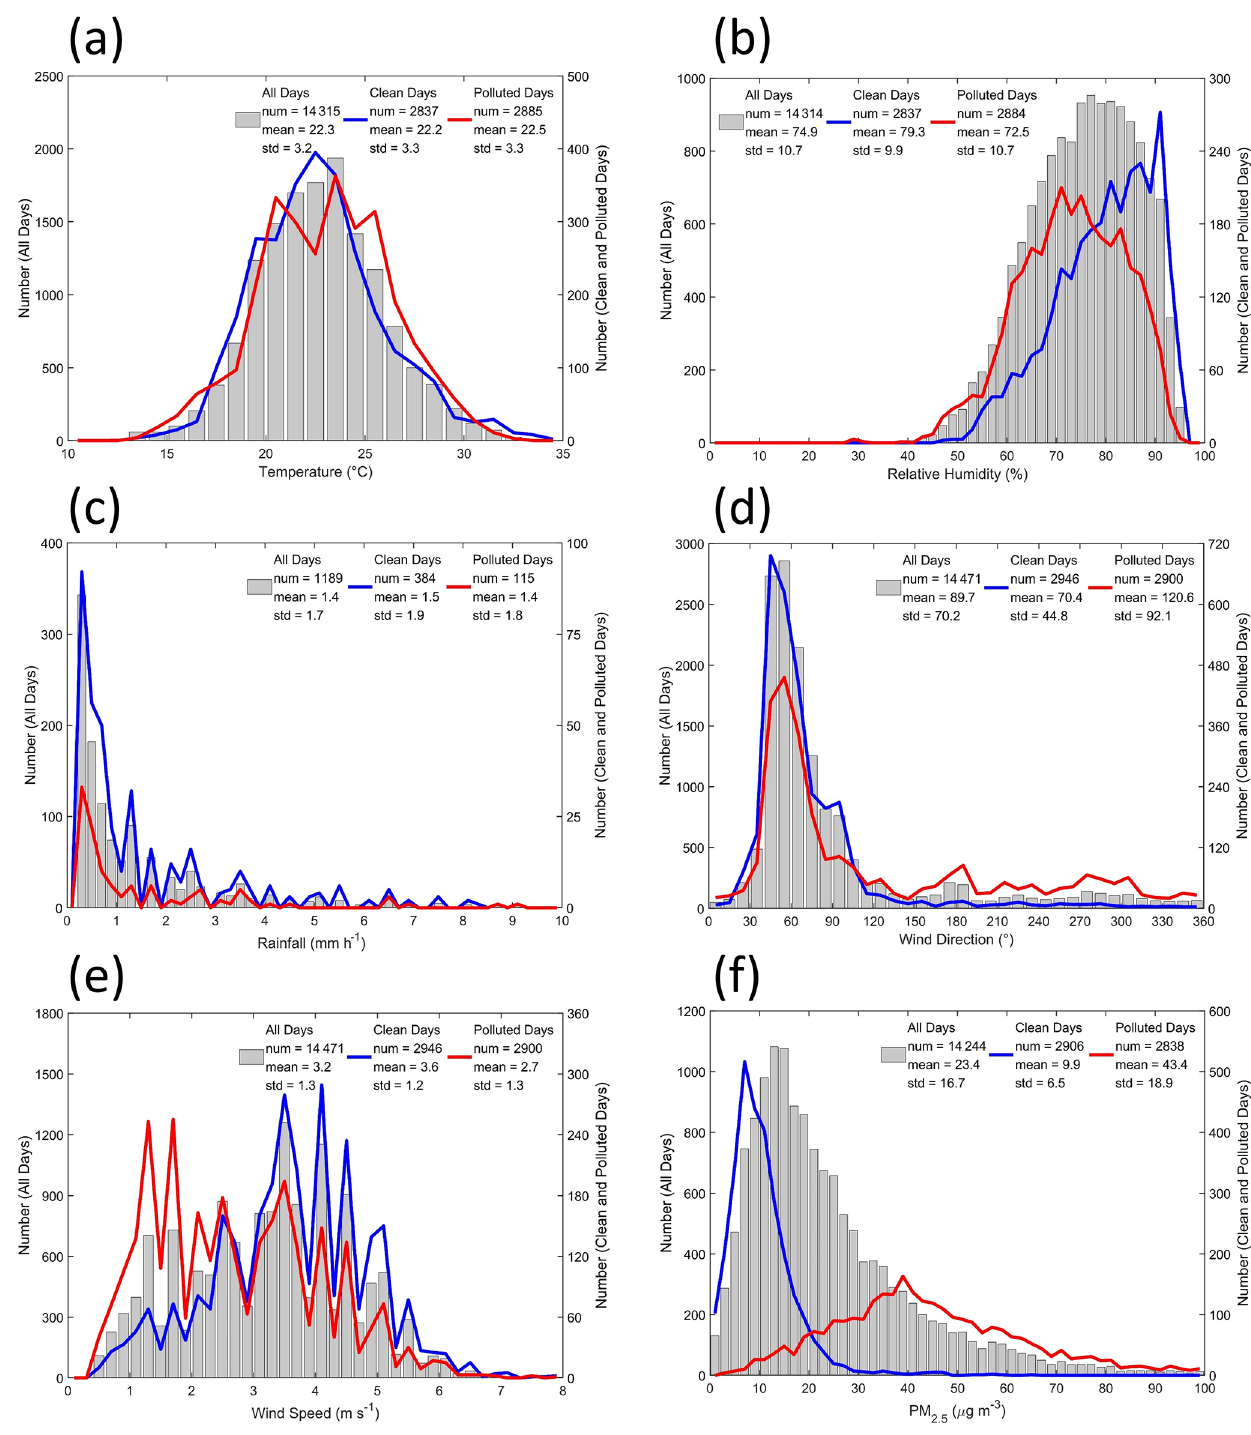
Figure 4. The distribution of (a) temperature, (b) relative humidity, (c) rainfall, (d) wind direction, (e) wind speed, and (f) PM 2 . 5 hourly data from the Pingzhen station from 15 October to 30 November 2005–2017. The gray bars are the distribution of all valid observations; the blue lines represent the clean days; and the red lines represent the polluted days. num: number; mean: mean; std: standard deviation.